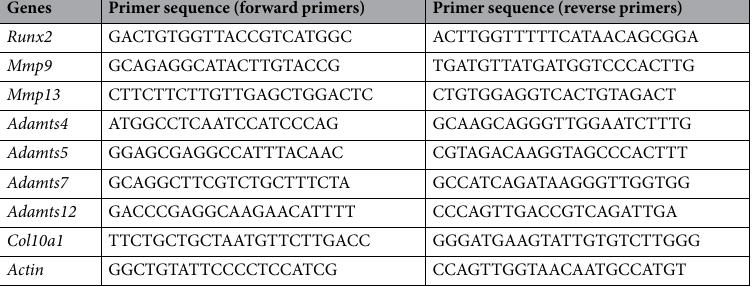
Table 1. The names of sequences of primers used in this